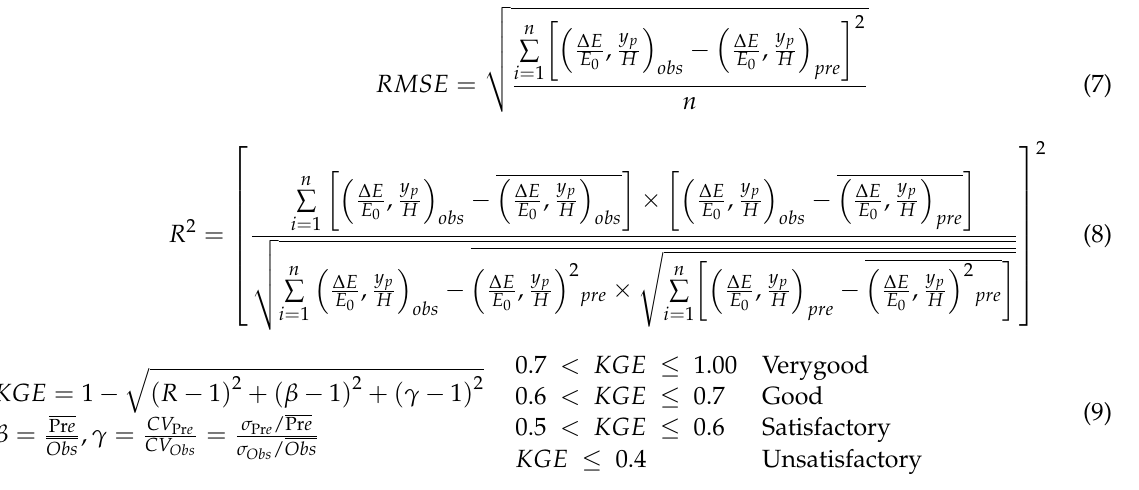
Table 2. Different kernel functions [24].